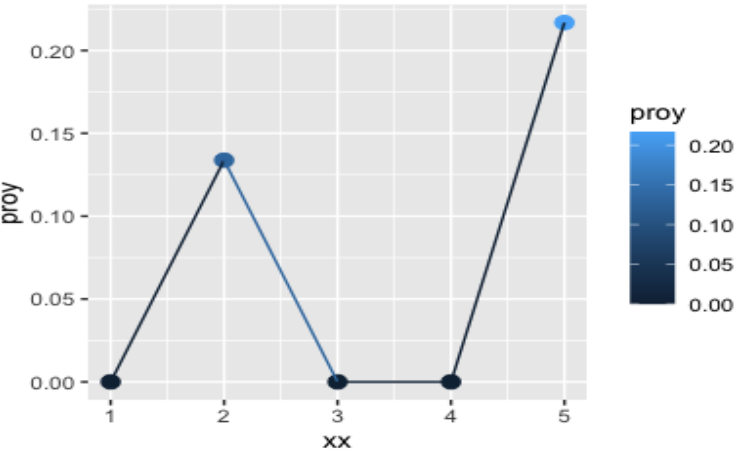
Figure 8. Representation of the projection of the object “carpet” on the universe U = {“sustainable”, “environment”, “wood”, “waste”,